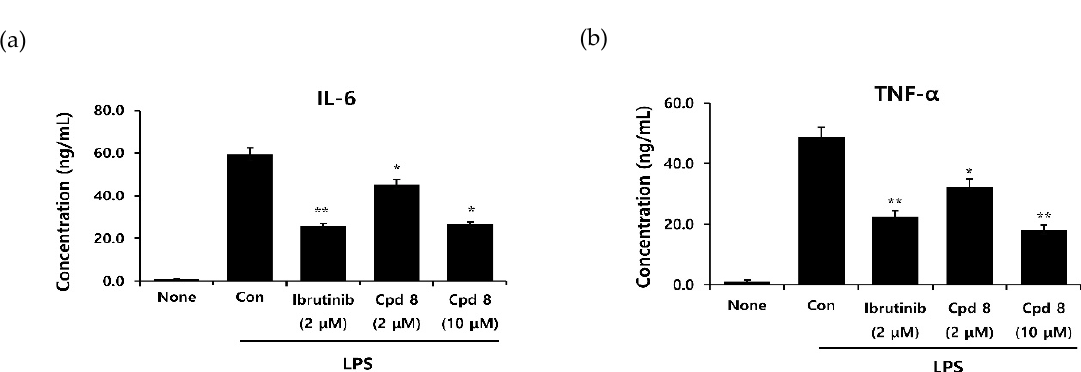
Figure 5. Effects of compound 8 on lipopolysaccharide (LPS)-induced human IL-6 ( a ) and TNF- α ( b ) release in THP-1 cells. Differentiated THP-1 cells were treated with compound 8 and then cotreated with LPS for 24 h. The levels of proinflammatory cytokines were determined using ELISA. * p < 0.05, ** p < 0.05, and *** p < 0.005 indicate significance, according to the t -test.